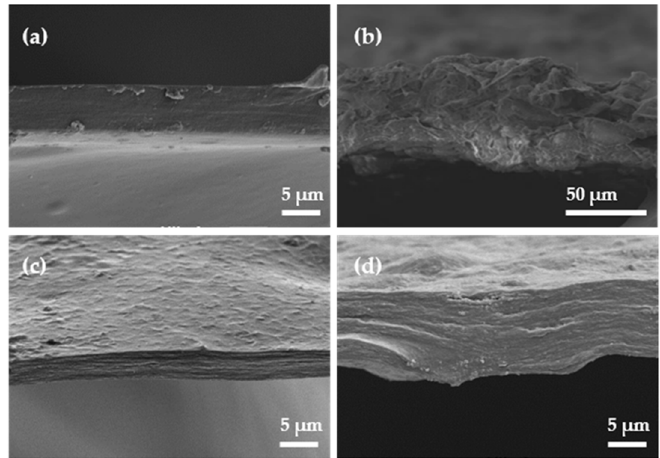
Figure A3. Representative SEM micrographs of the LbL freestanding films cross-section before crosslinking with genipin ( a ) CTR100, ( b ) BG100, ( c ) Cat50, and ( d ) CatBG50.